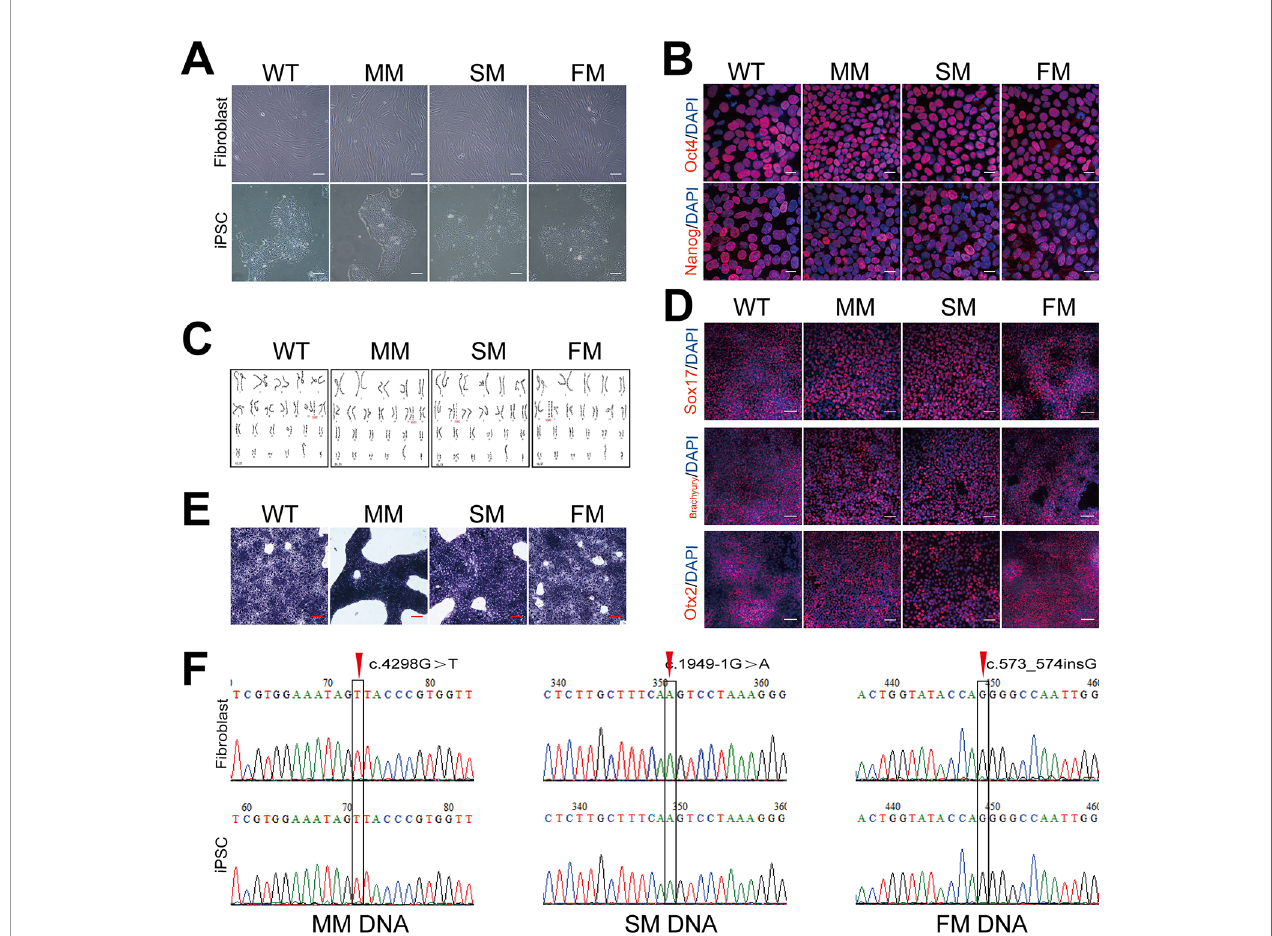
FIGURE 1 | Generation of WT and Alport iPSCs. (A) The morphology of fi broblasts and fi broblast- derived iPSCs. Scale bar, 100 m m. (B) Immuno fl uorescence staining of pluripotency markers, Oct4 (red) and Nanog (red). Nuclei were stained with DAPI (blue). Scale bar, 20 m m. (C) Karyotyping analysis of control (WT) and Alport syndrome patient iPSCs. (D) In vitro immuno fl uorescence staining of Sox17 (endoderm) (red), Brachyury (mesoderm) (red), and Otx2 (ectoderm) (red) for the three germ layers of WT and Alport syndrome patient iPSCs. Nuclei were stained with DAPI (blue). (E) Alkaline phosphatase staining of WT and Alport syndrome patient iPSCs. Scale bar, 100 m m. (F) Con fi rmation of the mutations of fi broblasts and iPSCs in COL4A5 missense mutation c.4298G > T, splicing mutation c.1949- 1G > A and frameshift mutation c.573_574insG. The right one represents the direct sequencing of COL4A5 splicing mutation cDNA from skin fi broblasts and iPSCs. The red arrow and black frame indicate the mutation sites. (MM, missense mutation; SM, splicing mutation; FM, frameshift